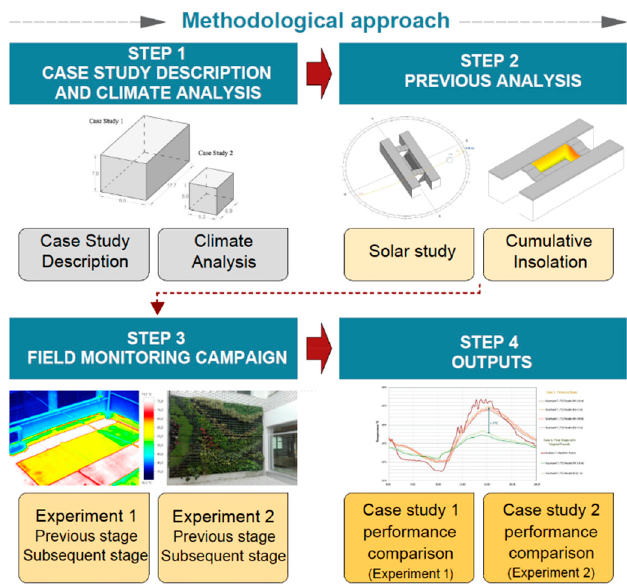
Figure 1. Overview of the methodological assessment.